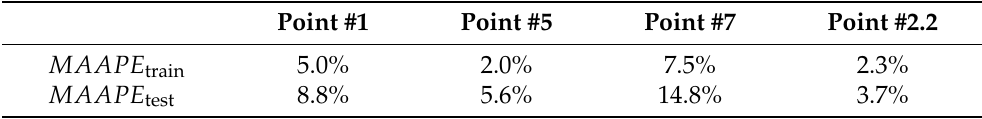
Table 5. MAAPE for t _ Ac 3 using sPGD